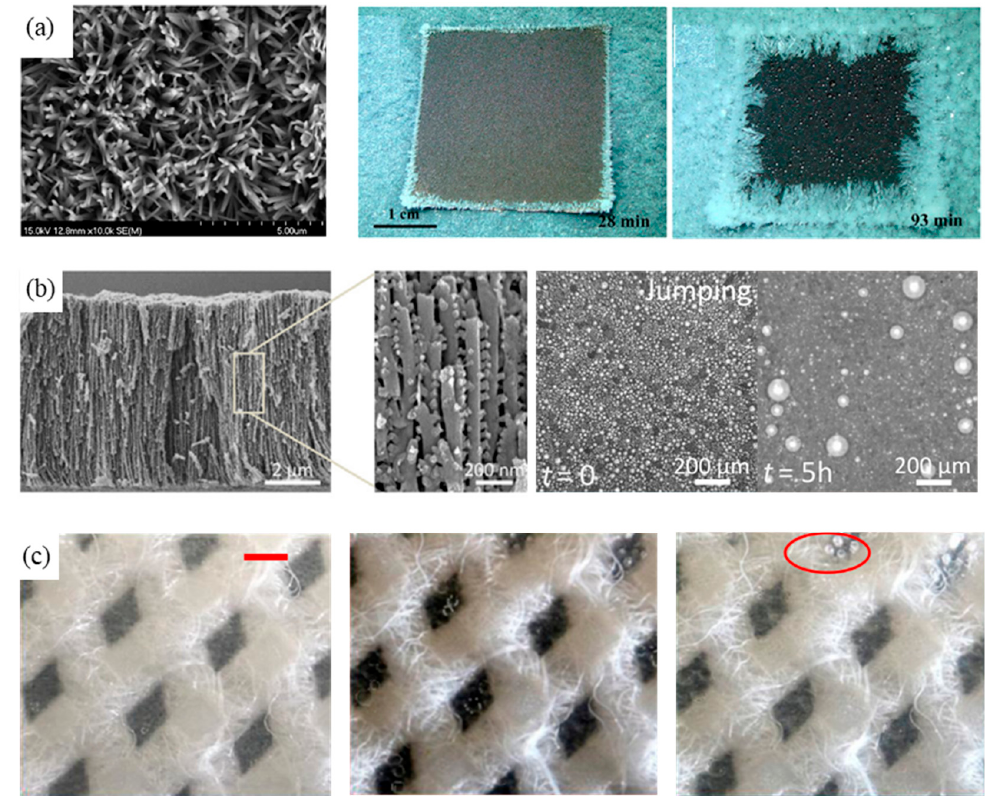
Figure 5. Frosting dynamics for different types of surfaces. ( a ) Superhydrophobic surface carrying nanoribbons, Reprinted with permission from [55], Copyright 2014 American Chemical Society. ( b ) Superhydrophobic surface with a three-dimensional nanowire network, Reprint from [56], Copy- right 2022 with permission from Elsevier. ( c ) Semipermeable membrane, Reprint from [57], Copyright 2022 with permission from Elsevier.